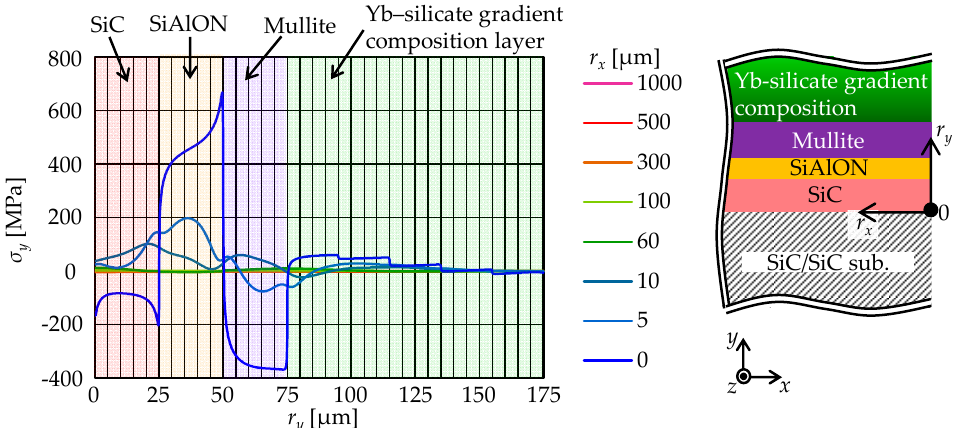
Figure A1. Thermal stress distribution near right interface edge of T/EBC deposited on SiC/SiC substrate without interface cracks.